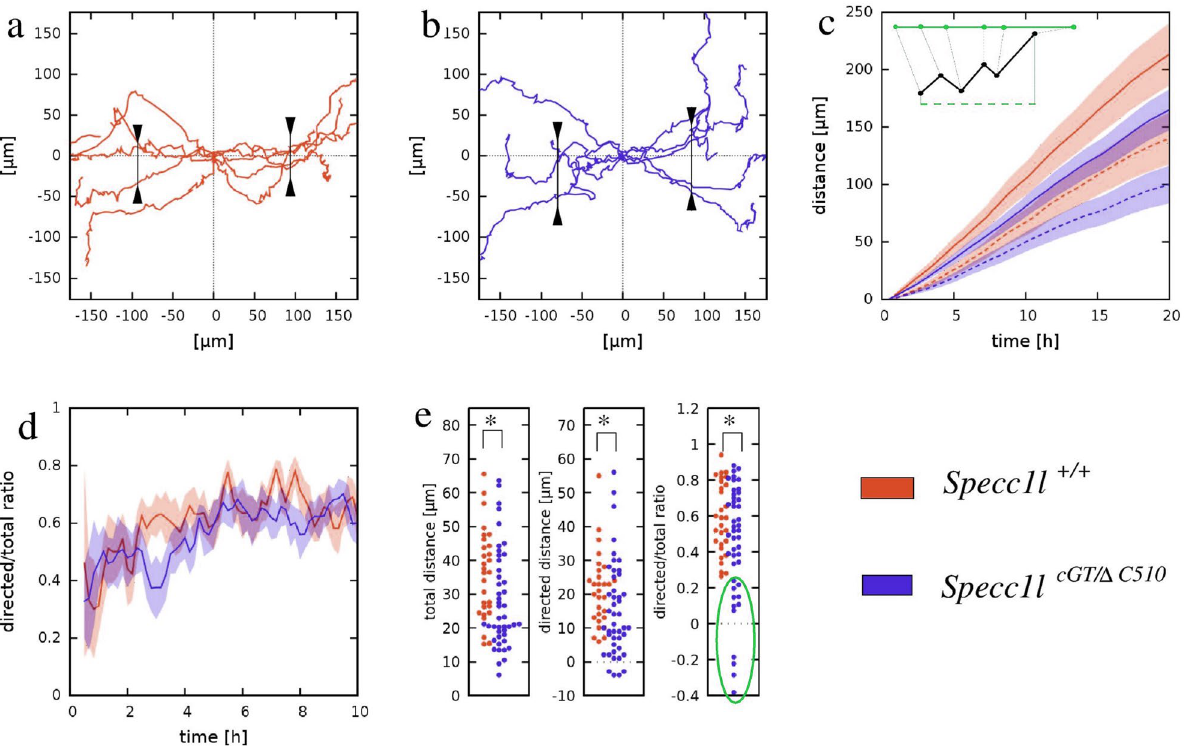
Figure 4. Specc1l cGT/ΔC510 MEPM cells exhibit defects in directional migration. ( a , b ) Representative paths of individual cells moving near the wound edge in WT ( a ) and mutant ( b ) cultures. Trajectories were shifted so that each originate at the origin. The WT cells exhibited a more directed movement to the open area compared to the mutant cells, as evidenced by the clustering of trajectories along the horizontal axis. Markers indicate the spread of trajectories: 90% of the trajectories pass through the drawn segments. ( c ) Individual cell trajectories were statistically characterized by their mean total path lengths (solid lines) and net displacements directed into the wound area (dashed lines). The inset demonstrates these concepts with an example trajectory (black). Both measures were plotted as a function of time elapsed, and show a reduction of motile activity in Specc1l -mutant MEPM cells. Lines represent an average of 40 cell trajectories, shaded areas indicate SEM. ( d ) The average ratio of the directed (net) displacement and total path length of the 40 cell trajectories, as a function of time. The typically lower values obtained for mutant MEPM cells indicate a guidance defect. ( e ) Statistical analysis of individual cell trajectories using the measures of total displacement, directed displacement and their ratio. The bee swarm plots show these quantities for each tracked cell, evaluated at 10 h culture time. The unguided population delineated by green oval was present only in cultures of Specc1l- mutant MEPM cells. The significance of differences was established by pairwise Welsh’s t-tests, yielding p-values of 0.01, 0.05 and 0.03 for the total path length, directed displacement and ratio data sets,